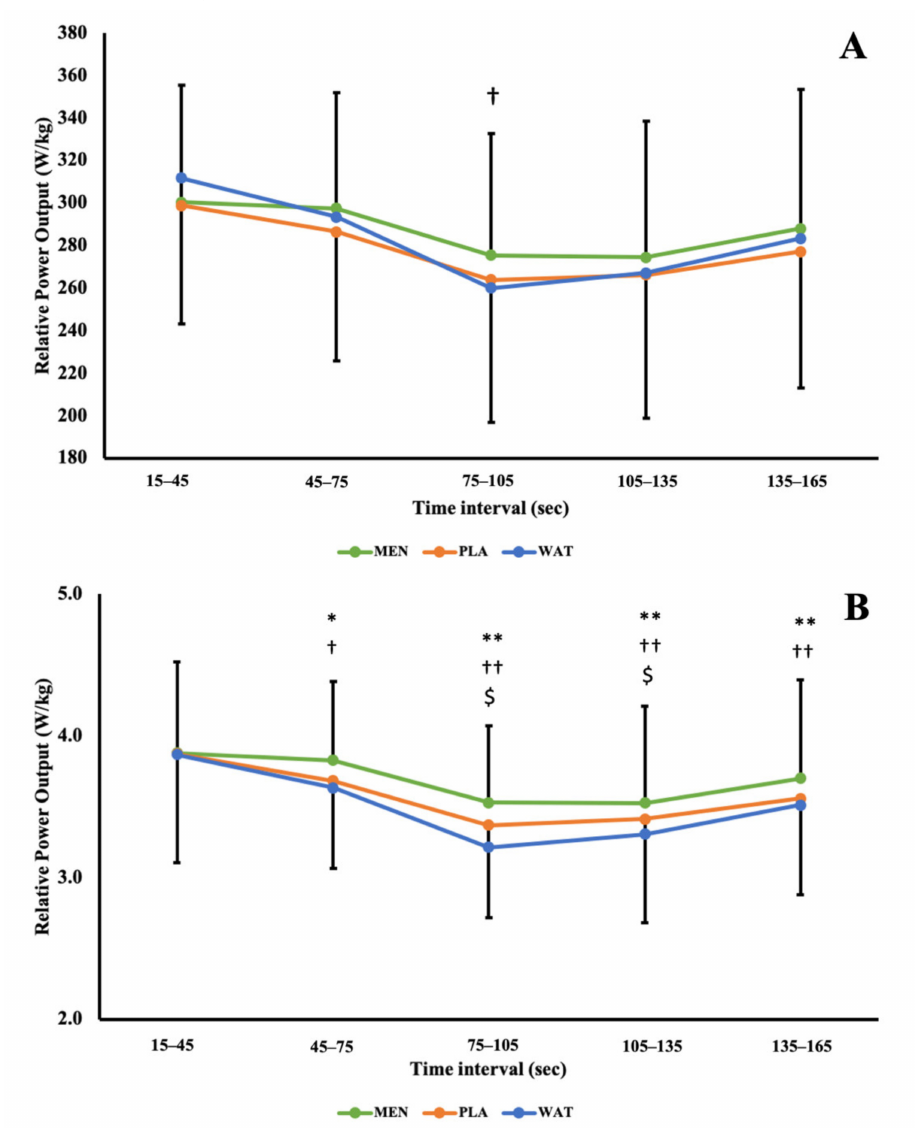
Figure 2. ( A ) Mean absolute power values (W) per condition. ( B ) Mean relative power values (W/kg) per condition. Error bars depict 1 SD; bidirectional error bars are not included per condition to maintain figure clarity. Symbols denote comparison (MEN vs. PLA *, MEN vs. WAT † and WAT vs. PLA $) and multiple symbols denote magnitude of effect (one, two and three of the same symbol denotes small, moderate and large effects,